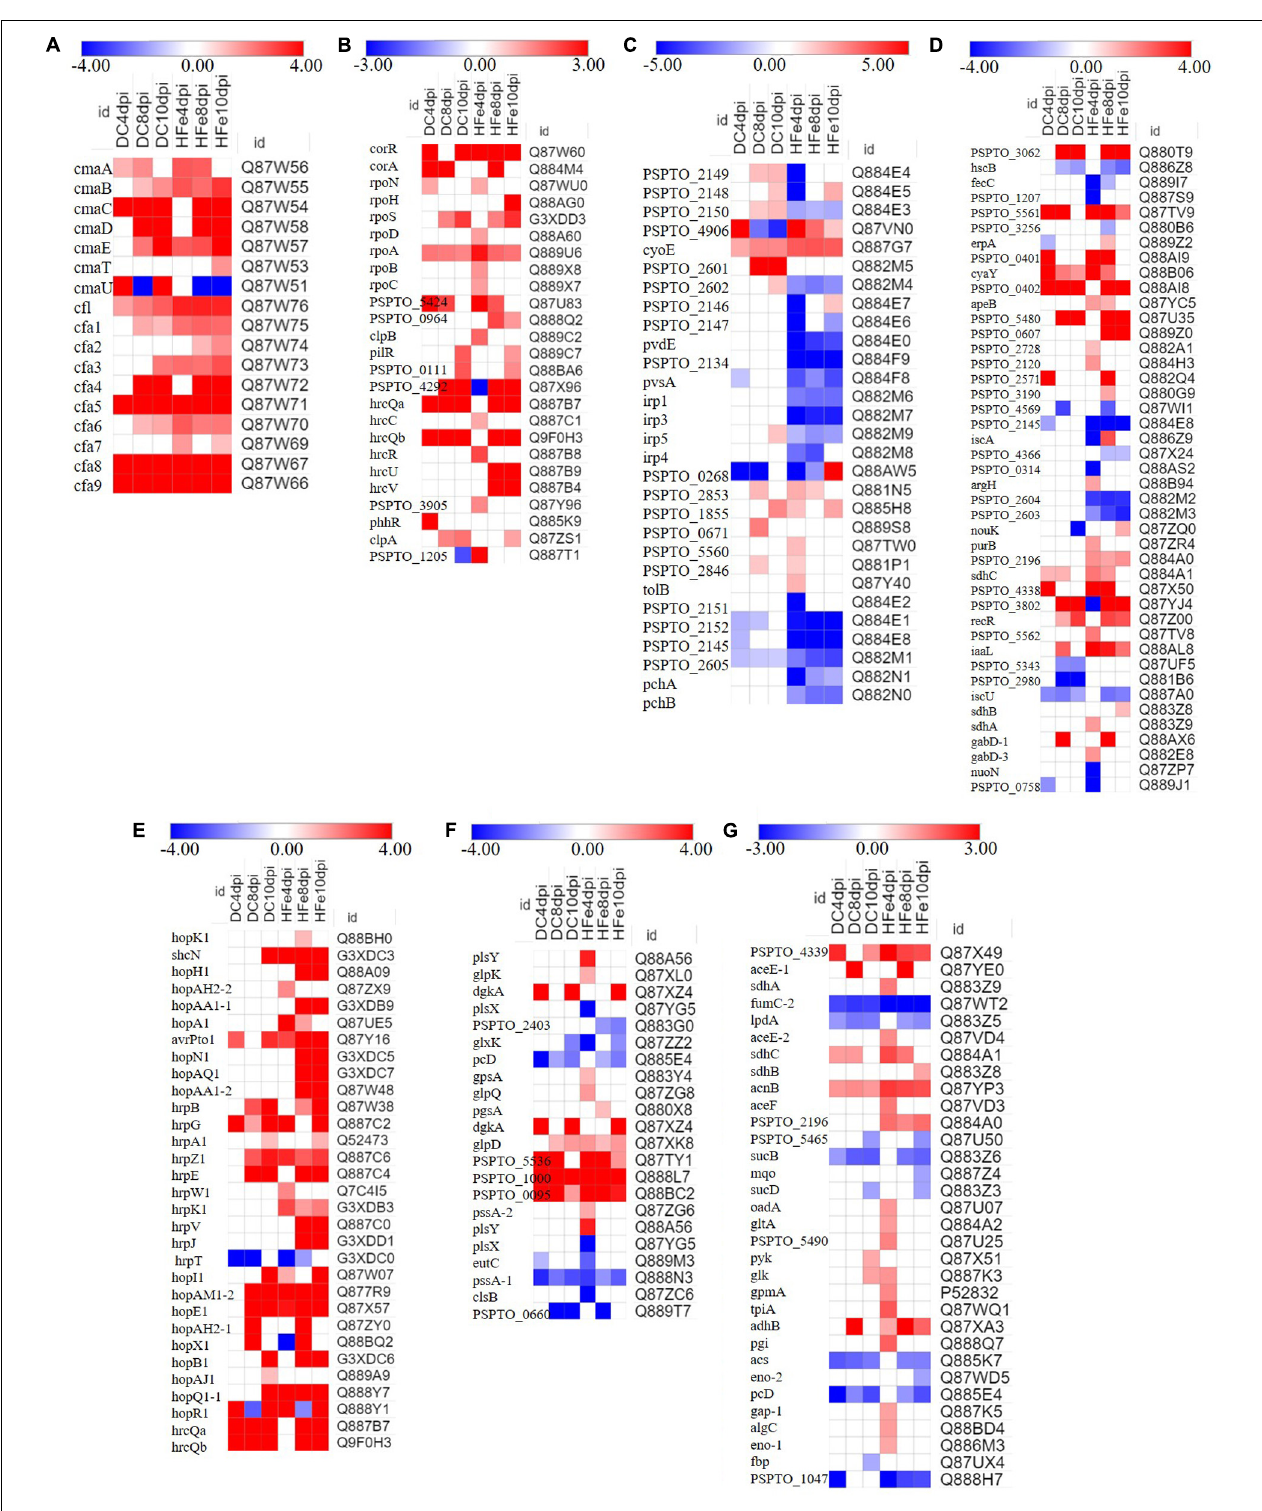
FIGURE 5 | Expression pattern of major differential expression proteins in samples at three time points. (A–G) shows the proteins that changed significantly in the treatment group with the addition of 20 µ mol/L FeCl 3 (DC) and 400 µ mol/L FeCl 3 (HFe) compared to the control group with no addition of FeCl 3 (0Fe), and the color bars show log2-fold change values between them, p -value < 0.05. Detailed data are presented in Supplementary Table S1 . Heatmap analysis used Scipy (Python, Version 1.0.0).